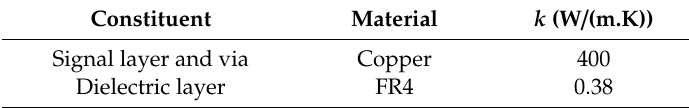
Table 4. Fitting of the 2s2p thermal metrics (Icepak ®